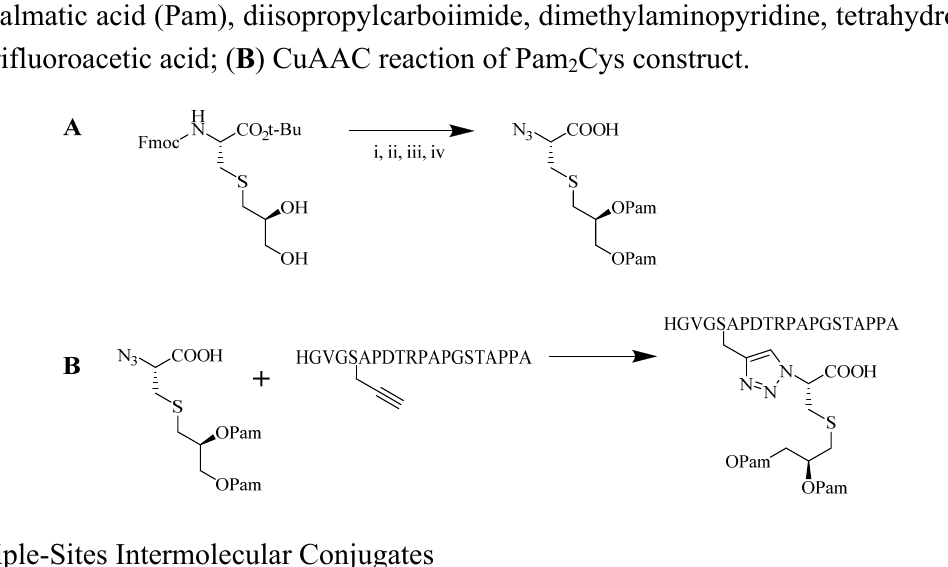
Figure 6. ( A ) synthesis of azide modified Pam Cys via four steps: (i) piperidine, 2 dichloromethane; (ii) imidazole-1-sulfonyl azide, potassium carbonate, methanol; (iii) palmatic acid (Pam), diisopropylcarboiimide, dimethylaminopyridine,